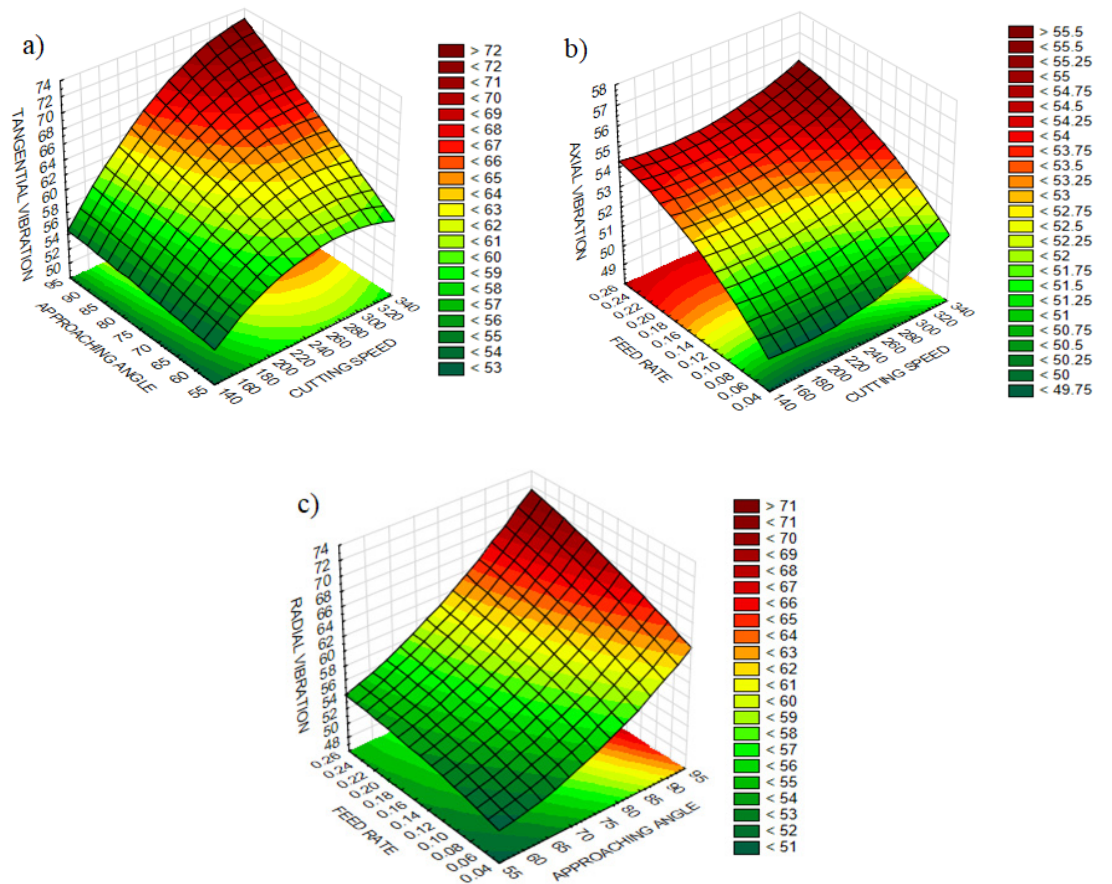
Figure 3. The influential parameters on 3 components of vibration ( a ) The e ff ect of cutting edge angle Figure 4. The influential parameters on 3 components of vibration ( a ) The effect of cutting edge and cutting speed on tangential vibration, ( b ) The e ff ect of feed rate and cutting speed on axial vibration, angle and cutting speed on tangential vibration, ( b ) The effect of feed rate and cutting speed on axial ( c ) The e ff ect of cutting edge angle and feed rate on radial vibration, ( c ) The effect of cutting edge angle and feed rate on radial vibration